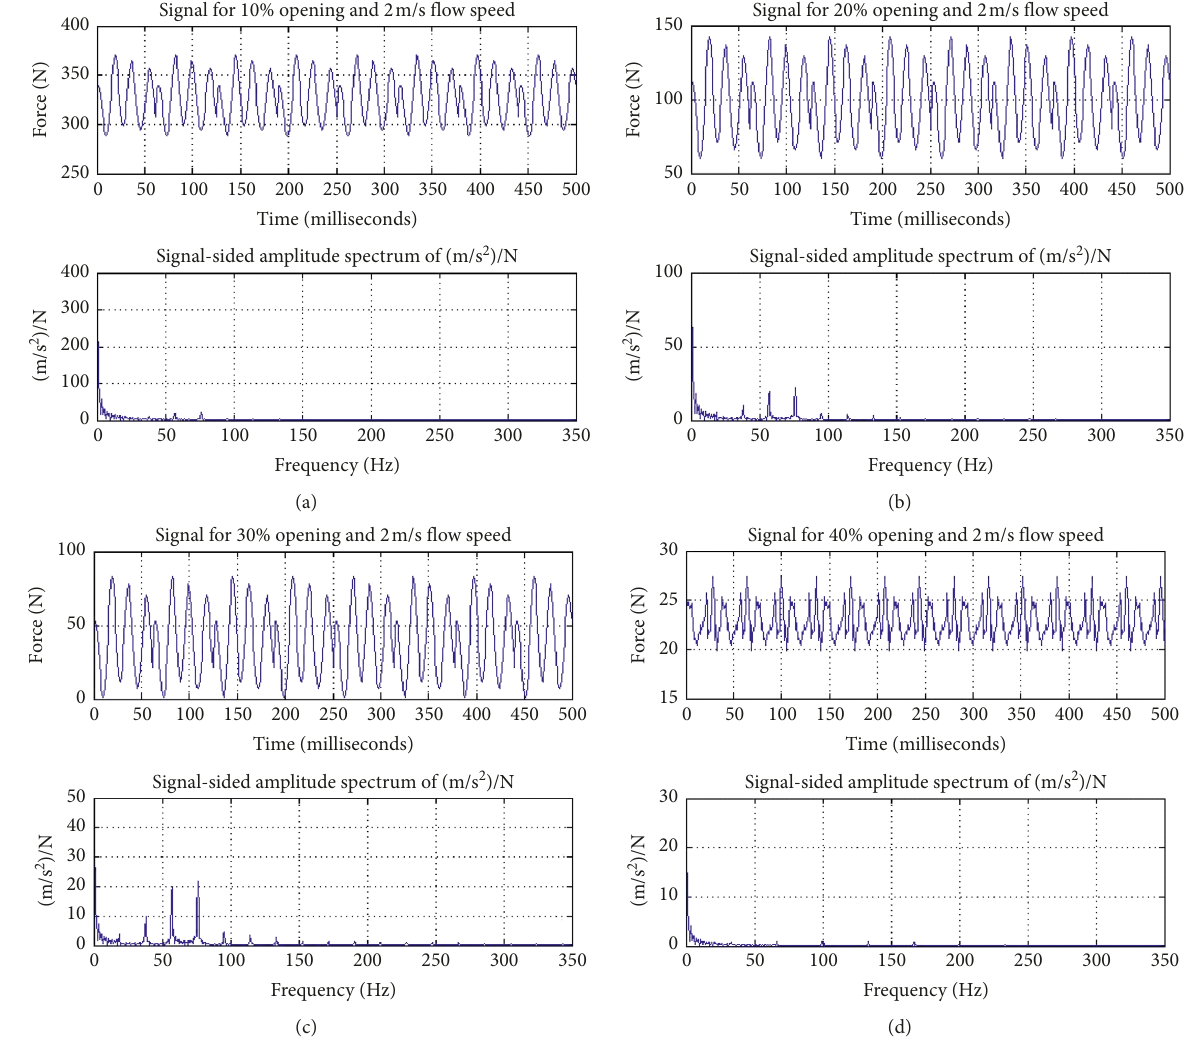
Figure 8: A theoretical representation of flat face plug at a flow velocity of 2m/s under different valve openings. (a) 10% valve opening; (b) 20% valve opening; (c) 30% valve opening; (d) 40% valve